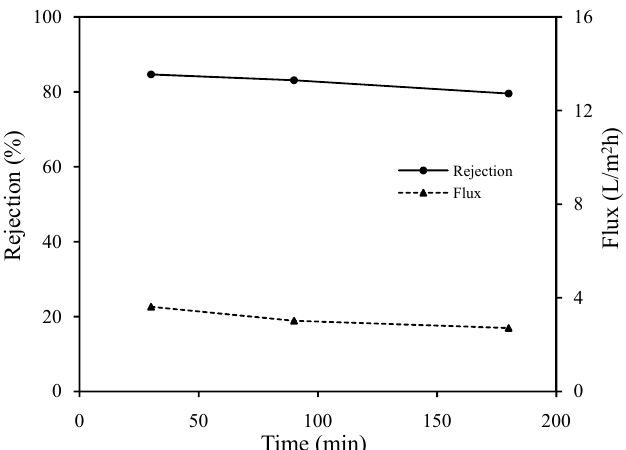
Fig. 10. Permeate flux and rejection percent of cobalt ions by the MMM containing 22 wt. % PES, 0.6 wt.% fMWCNTs versus time (PES-%0.6 fMWCNTs, 20 bar, 40 L/h, 20 ppm Co(NO 3 ) 2 , pH=5.5±0.1)